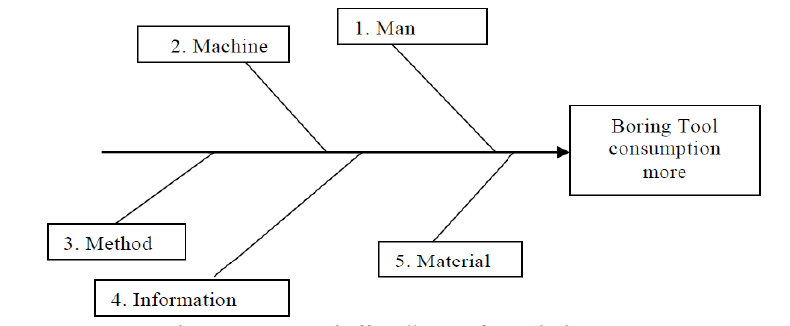
Figure 4. Cause and effect diagram for